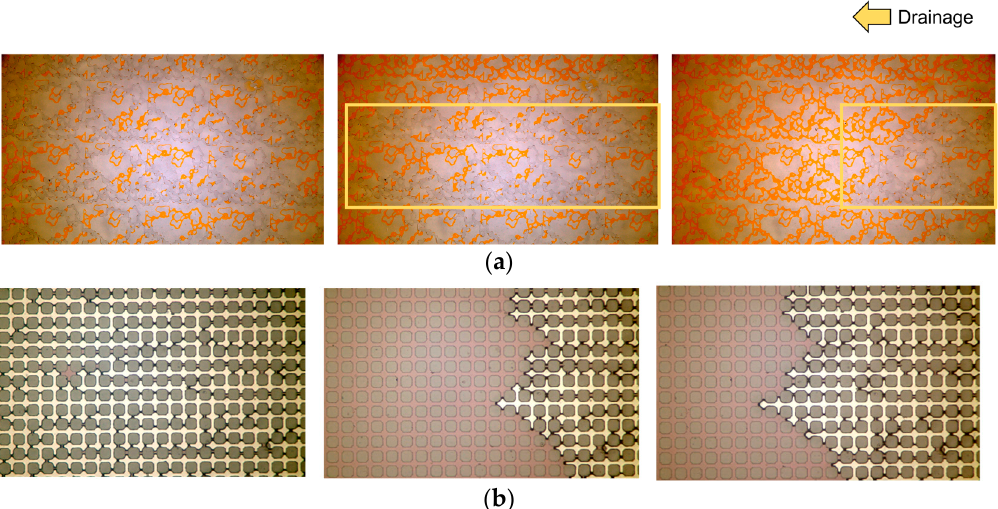
Figure 12. Images of the drainage process at Ca = 10 − 4 and at three different times for ( a ) HO49Y and ( b ) GRID01 grid. In the last time-step, the flow reached steady-state conditions. Air is white and water is orange in ( a ) and pink in ( b ).